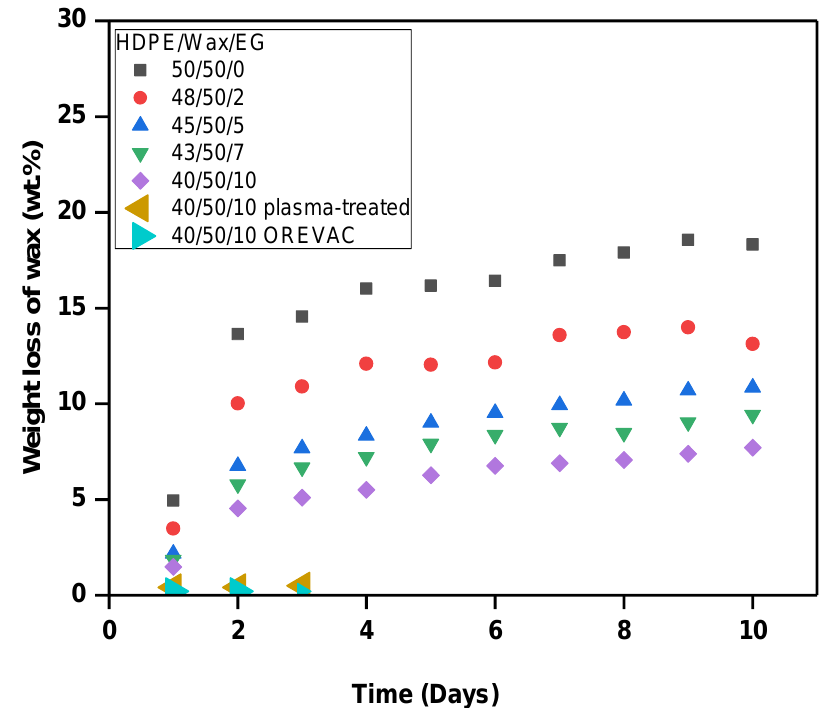
Figure 3. The leakage experiment of SSPCMs.